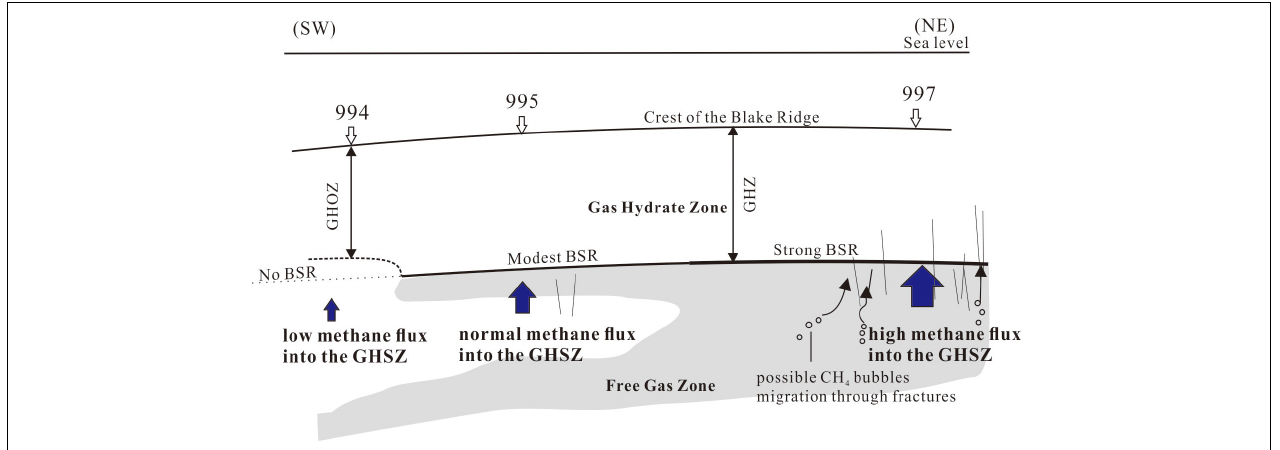
FIGURE 4 | Conceptual representation of the methane hydrate reservoir system at the Blake Ridge. From flank Site 994 to flank Site 995 and finally to crest Site 997, the deep methane flux (dark blue arrow) is changeable from low to high, corresponding to no BSR to strong BSR occurrence. FGZ (light gray) is beneath the BSRs. The methane hydrate-bearing zone at Site 994 (GHOZ) does not extend to the BSRs depth. However, thicker hydrate occurrences (GHZ) appear at Sites 995 and 997, which both extend to the